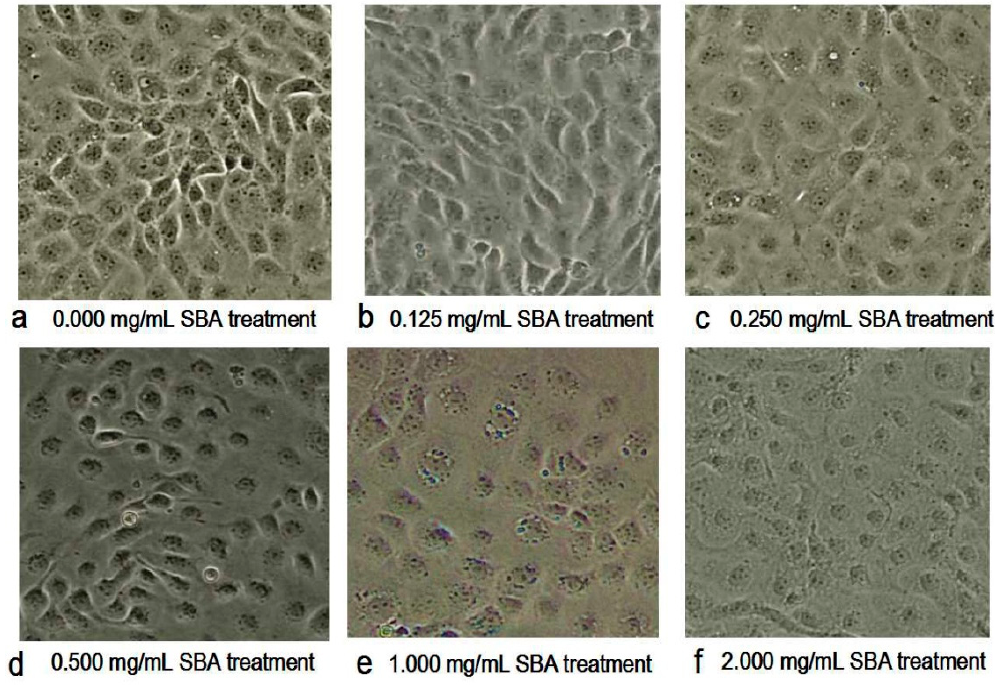
Figure 2. ( a – f ) Effect of soybean agglutinin (SBA) on the morphology of IPEC-J2 cells (200×). IPEC-J2 was cultured with 0, 0.125, 0.25, 0.5, 1.0 or 2.0 mg/mL SBA for 24 h. Cell morphology was observed in different treatments by contrast microscopy at 200× magnifications. ( a ) Control, 0.000 mg/mL SBA treatment; ( b ) 0.125 mg/mL SBA treatment; ( c ) 0.250 mg/mL SBA treatment; ( d ) 0.500 mg/mL SBA treatment; ( e ) 1.000 mg/mL SBA treatment; ( f ) 2.000 mg/mL SBA treatment.